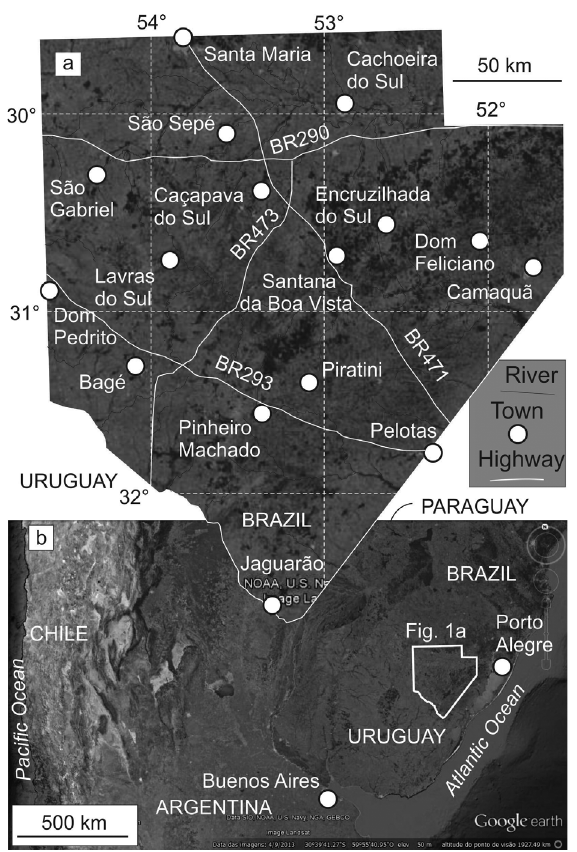
Figure 1 - Location of study area in GoogleEarth satellite images, indicating main geographic references. See the colors in the online version.